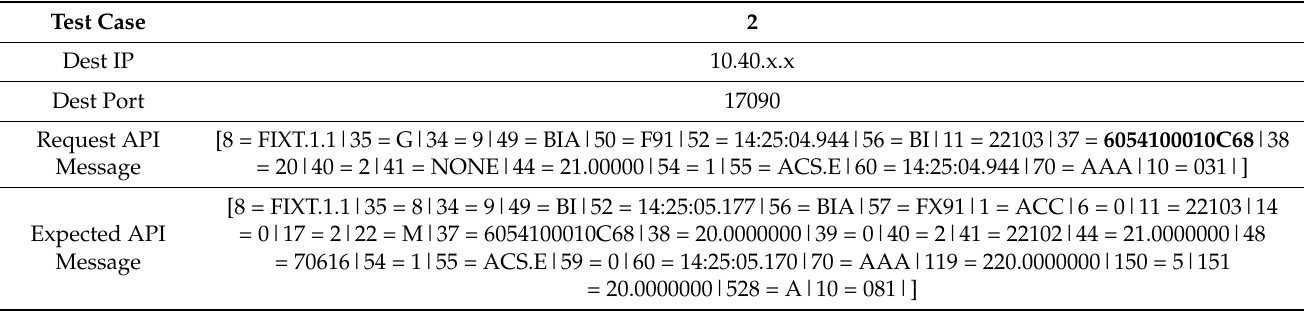
Table 3. An example of a test case for FIX API protocol extracted from the pcap file—update